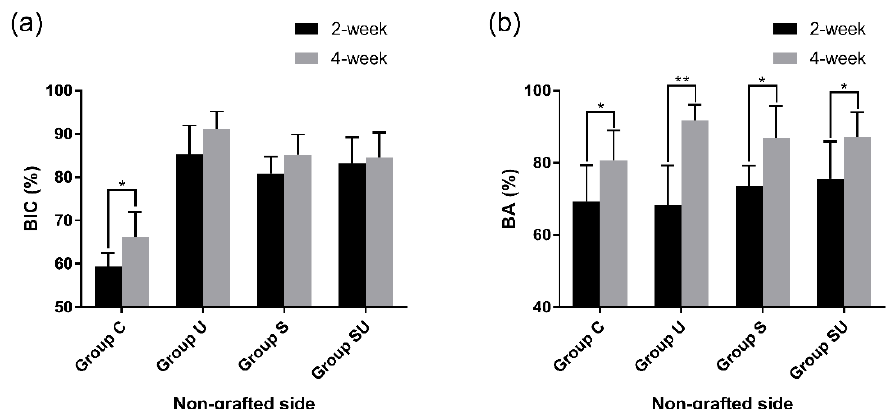
Figure 10. Comparisons between the 2- and the 4-week groups on the nongrafted sides, as assessed by histomorphometry. ( a ) BIC; ( b ) BA. Data are expressed as mean ± standard deviations. Asterisks indicate statistically significant differences among the groups (* p < 0.05 and ** p < 0.01). Error bars show the standard deviations. BIC, bone-to-implant contact; BA, bone